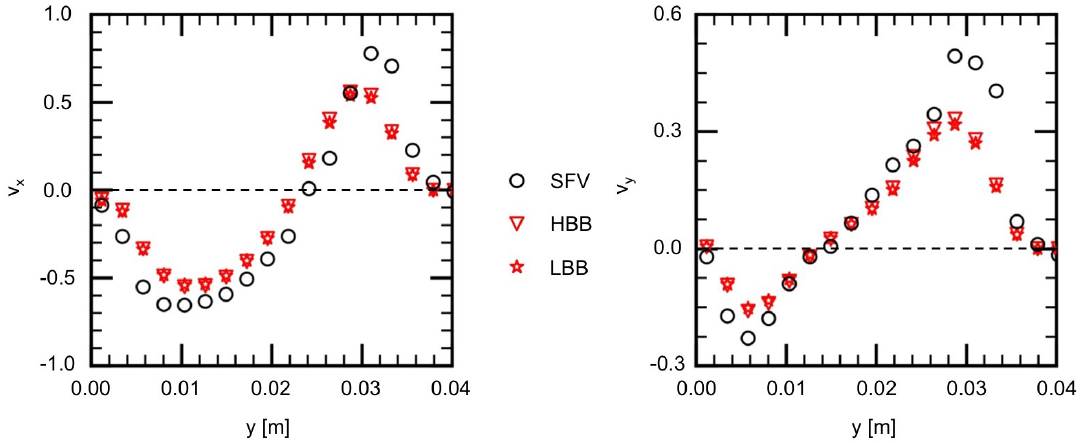
Figure 11. Comparison of velocity components between measured (SFV), HBB and LBB (line V1).